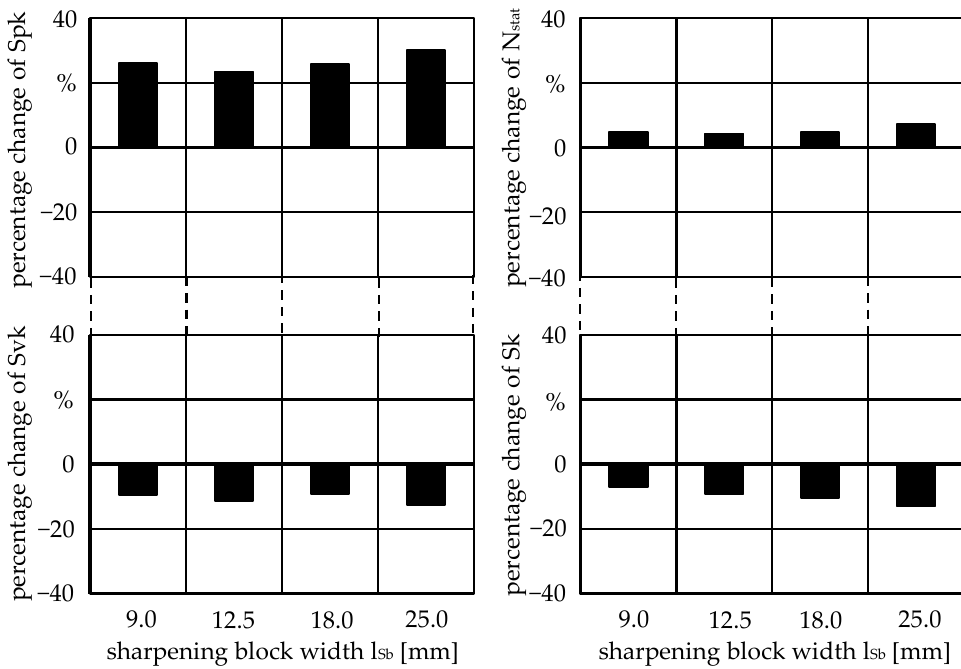
Figure 9. Influence of the grain size of the sharpening block d kSb on the profile height.